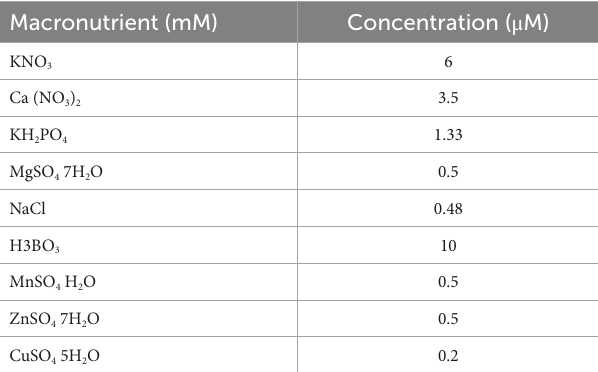
TABLE 2 Chemical composition of nutrient